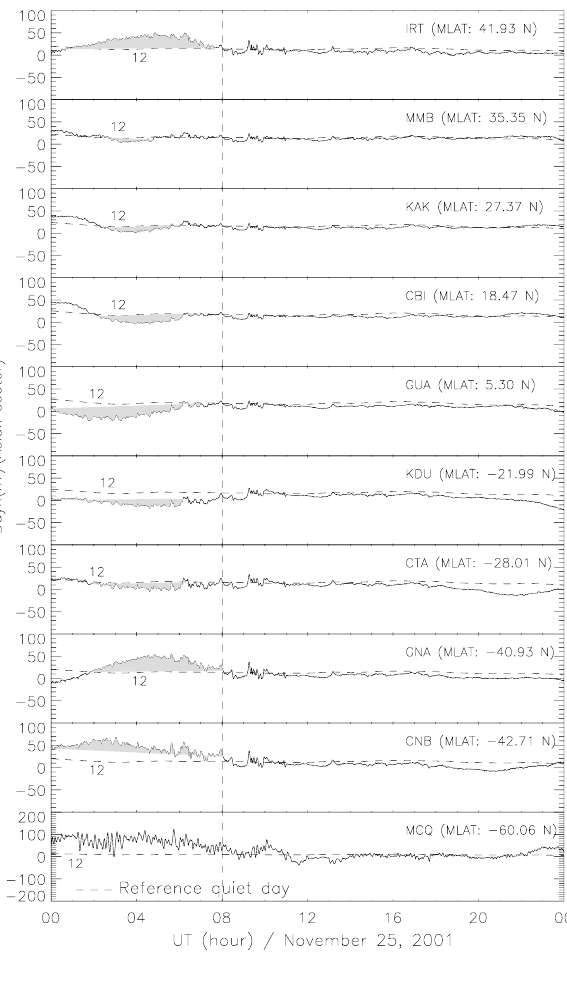
Fig. 8. Idem as Fig. 7, on 25 November